Question: Provide a one-line summary of what is displayed.
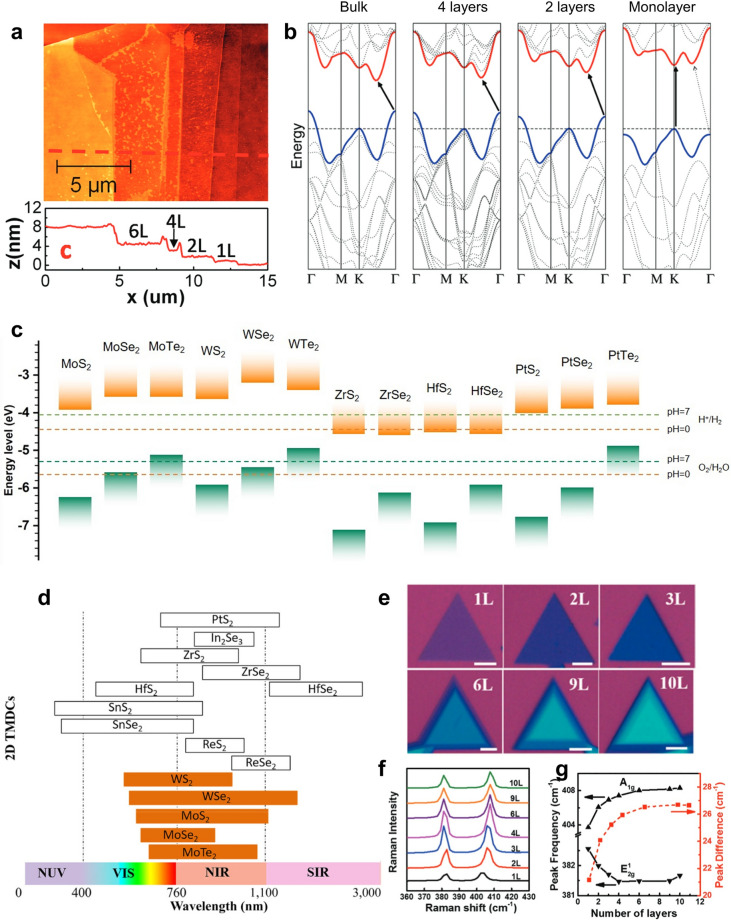
Answer: a Atomic force microscope (AFM) image of the exfoliated MoS 2 sample; b calculated band structures of MoS 2 with different layers [ 24 ]. Copyright 2010 American Chemical Society. c VBM and CBM positions of TMDs monolayers calculated by DFT method. The vacuum level is zero used as reference. Data collected from Ref. [ 73 ]. Copyright 2013 American Chemical Society. d Spectral responses of 2D TMDCs. NUV, VIS, NIR, and LIR represent near ultraviolet, visible, near infrared, and longwave infrared, respectively [ 75 ]. Copyright 2020 Springer Nature. e Optical images of MoS 2 flakes with different layers on Si substrate; f Raman spectra of the MoS 2 flakes with different layers. g Peak frequency variation of E 2g 1 and A 1g Raman mode and their difference [ 76 ]. Copyright 2017 Wiley-VCH